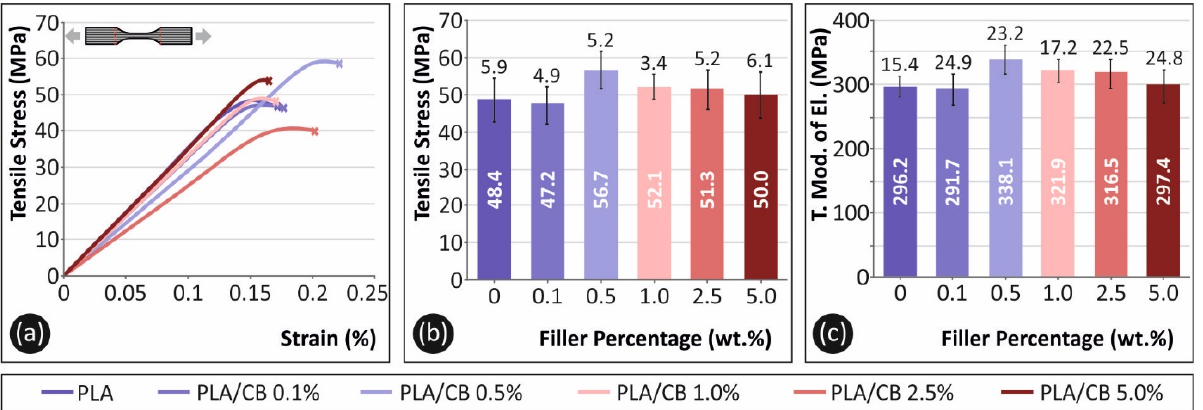
Figure 7. ( a ) Tensile stress (MPa) vs. strain (%) representative curves for neat PLA and PLA/CB nanocomposites. ( b ) average tensile strength, and ( c ) average tensile modulus of elasticity values along with the calculated standard deviation values, both as a function of CB filler loading (wt.%).